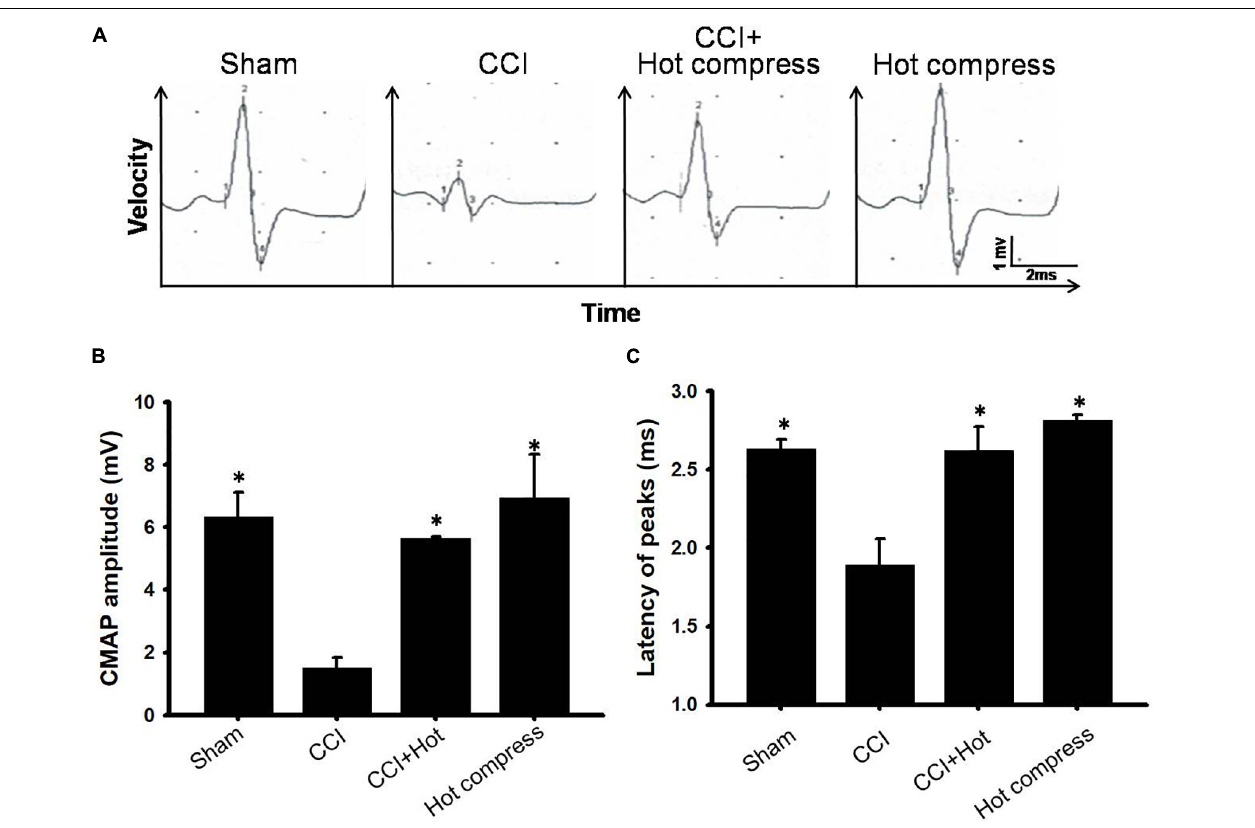
FIGURE 4 | The effects of hot compress on a peak-to-peak amplitude and latency of the compound muscle action potentials (CMAPs) of the rat sciatic nerve. Panel (A) showed representative CMAPs tracings for sham, CCI, CCI+Hot compression, hot compress alone groups on the postoperative day 28. (B) The quantification of the hot compress effect on peak-to-peak amplitude and (C) latency is shown, respectively. Data were analyzed by one-way ANOVA with post hoc Dunnett’s test. ∗ p < 0.001 was considered significant as compared with the CCI group, n =